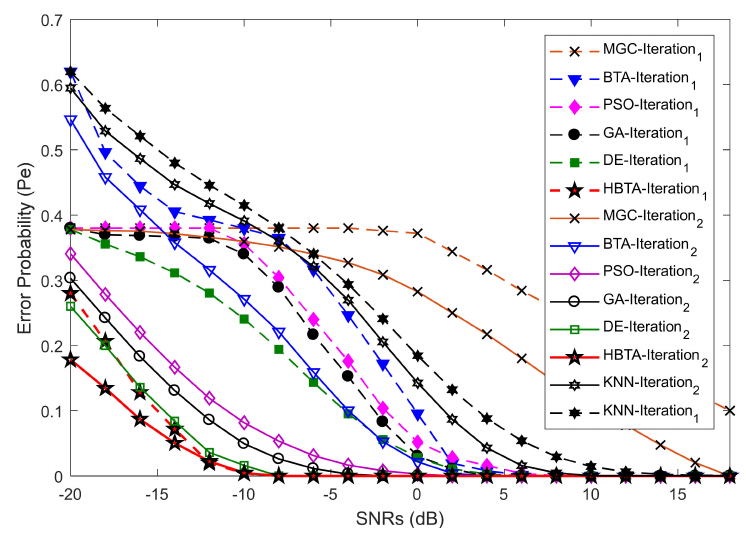
Figure 13. Error probability vs. SNRs in the presence of AY-AYC users with sensing iterations 1 (60) and iterations 2 (85).